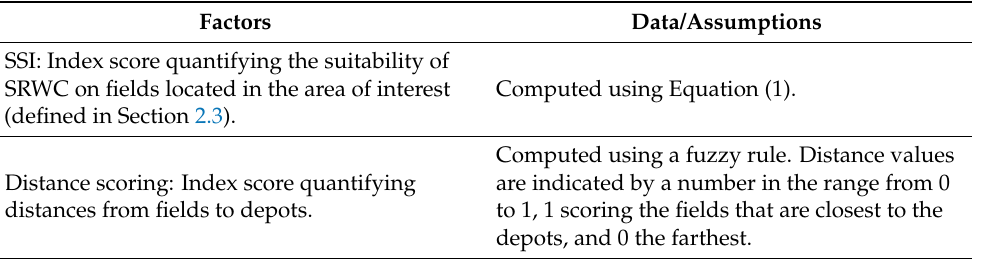
Table 2. Factors considered for updated SSI.